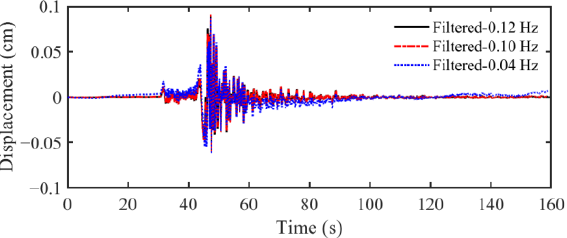
Figure 12. Displacement curves after filtering using different cut-off frequencies.